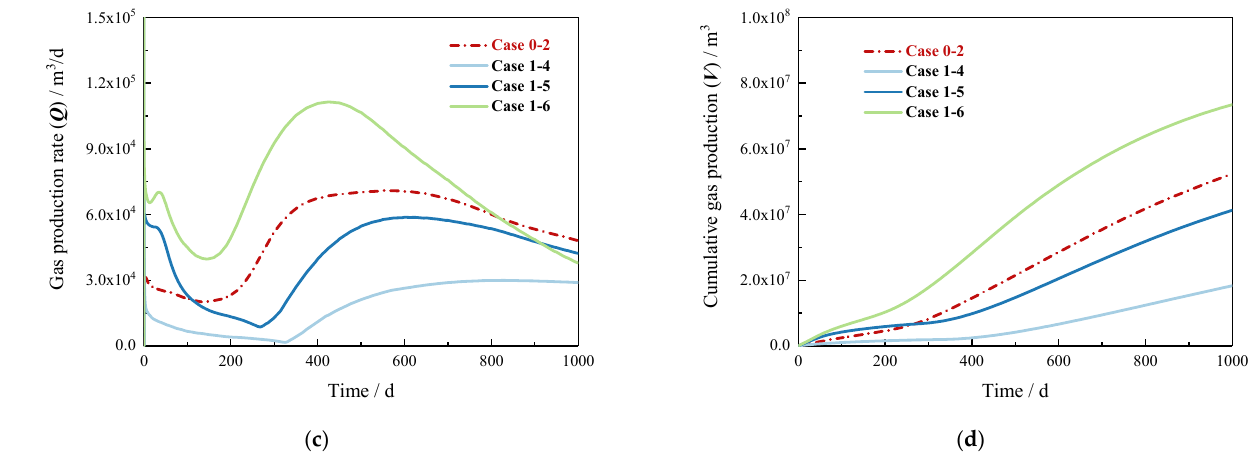
Figure 7. Gas production characteristics for the open-hole position adjustment: ( a ) gas production rate (1 MPa); ( b ) cumulative gas production (1 MPa); ( c ) gas production rate (4 MPa); and ( d ) cumulative gas production (4 MPa).